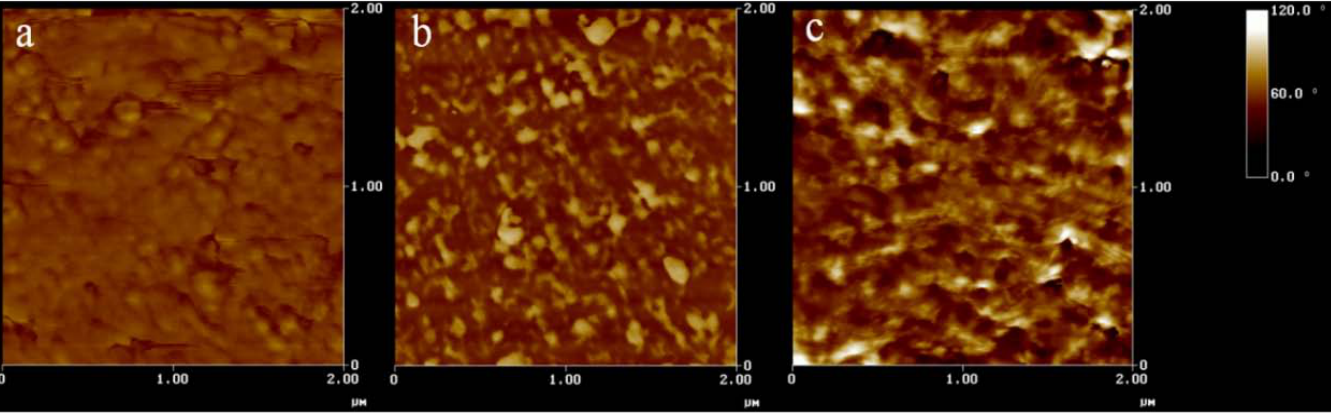
Figure 8. AFM phase images of samples ( a ) mPU, ( b ) mPUPB5, ( c ) mPUPB10. The contrast covers phase variations in the 0°–120°